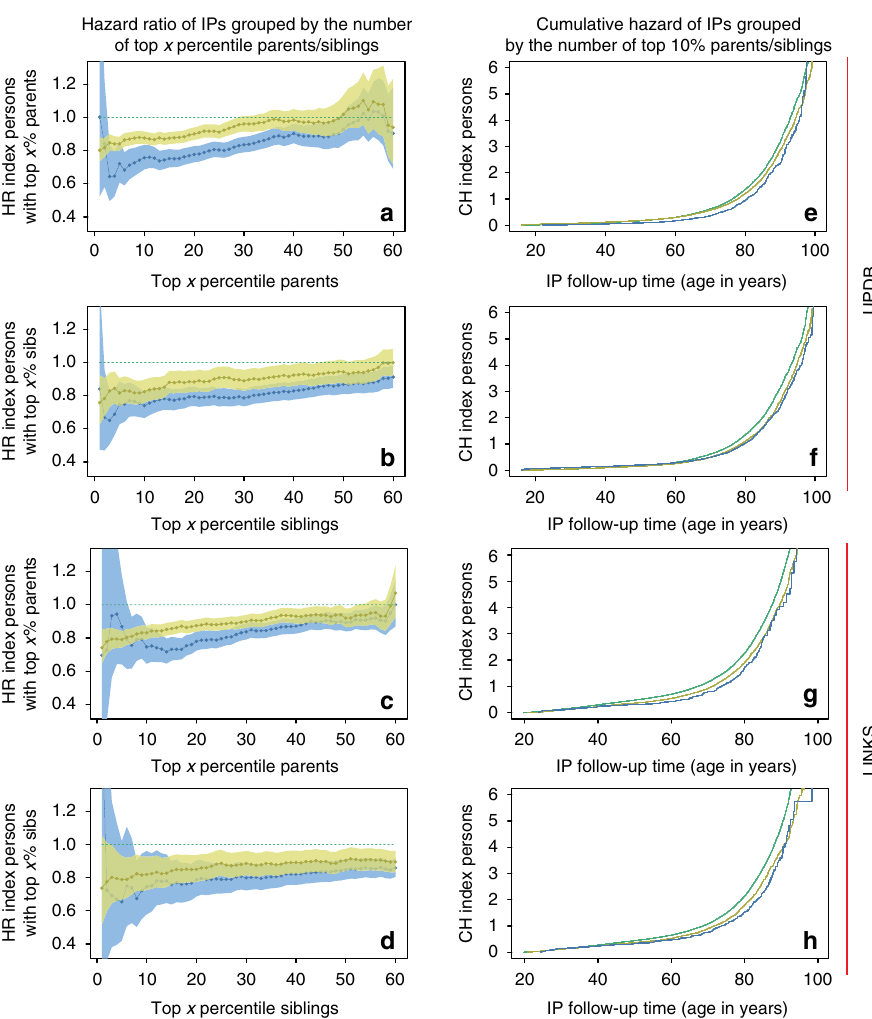
Fig. 2 Survival of IPs with relatives belonging to the 1st until 60th percentile survivors of their birth cohort. This fi gure depicts the hazard ratio (HR) for IPs (left column, panels a – d ) with 1 and 2 parents (panels a and c ) or 1 and 2 + siblings (panels b and d ) belonging to the top x percentile ( x = 1,2,3, … , 60) survivors of their birth cohort. The percentile groups ( x -axis) are mutually inclusive, meaning that a fi rst-degree family member who belonged to the top 1% also belonged to the top 5%, etc. The fi gure also depicts the cumulative hazard (CH) for index persons (IPs, right column, panels e – h ) with 1 and 2 parents (panels e and g ) or 1 and 2 + siblings (panels f and h ) who belong to the top 10%. Green (dotted) lines present the reference group of 0 top x percentile parents or siblings, yellow lines represent 1 top x percentile parents or siblings, blue lines represent 2 or 2 + top x percentile parents or siblings. Left column: x -axes represent the top x birth cohort-based survival percentile, the y -axes represent the hazard ratio (HR) of dying for IPs having 1 and 2 or 2 + top x percentile parents or siblings compared to having 0 top x percentile parents or siblings. Right column: x -axes represent IP years of survival, y -axes represent the IPs ’ cumulative hazard of dying while having 1 and 2 or 2 + top 10th percentile parents or siblings compared to having 0 top 10th percentile parents or siblings. All estimates are adjusted for religion (UPDB only), sibship size, birth cohort, sex, socio-economic status, mother ’ s age at birth, birth order, birth intervals, twin birth, and number of top 10% parents or number of top 10% siblings for the sibling and parent analyses, respectively. Error